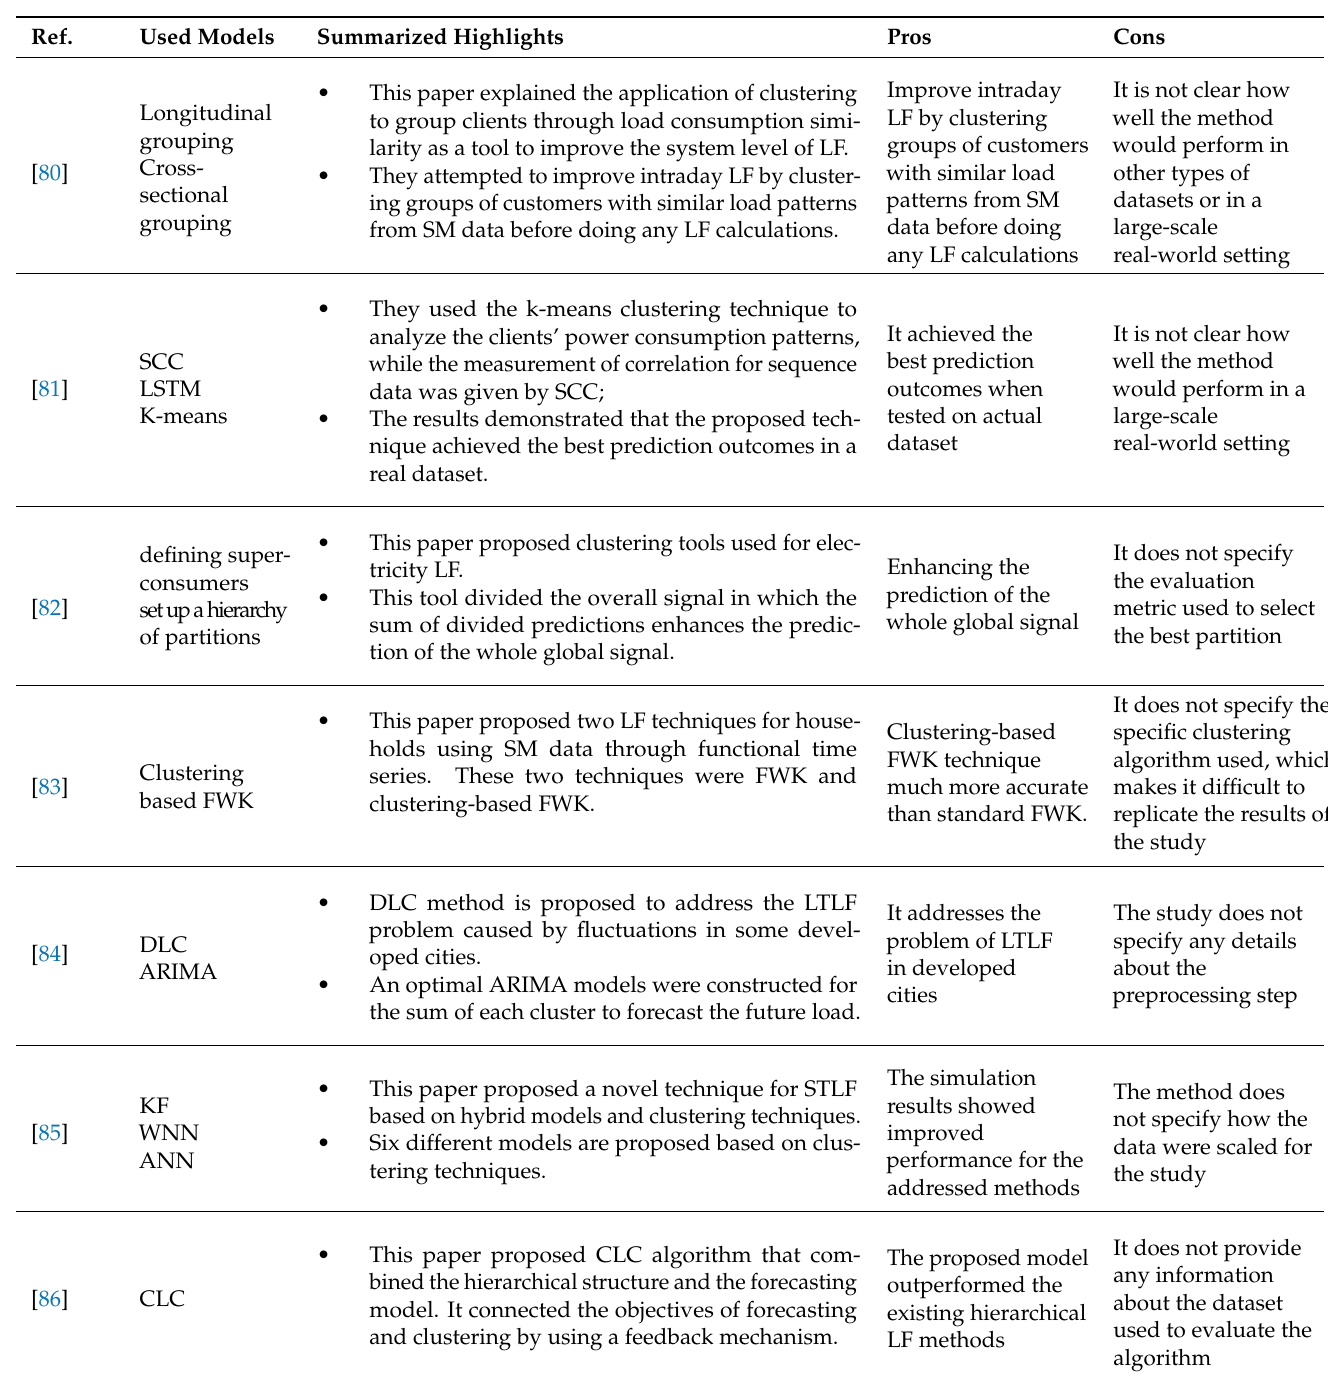
Table 3. Clustering-based load forecasting